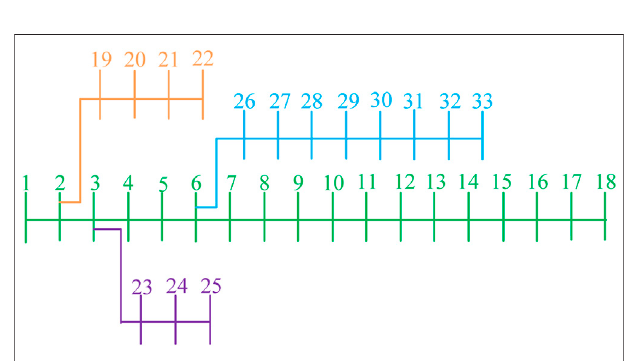
FIGURE 5 | IEEE 33-bus distribution